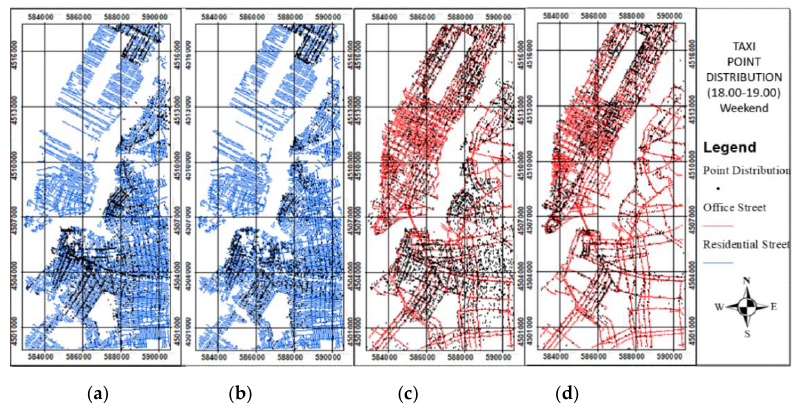
Figure 14. Taxi point distribution at the weekend peak time (18:00 – 19:00): ( a ) origin before data cleaning; ( b ) origin after data cleaning ( c ) destination before data cleaning; ( d ) destination after data cleaning.